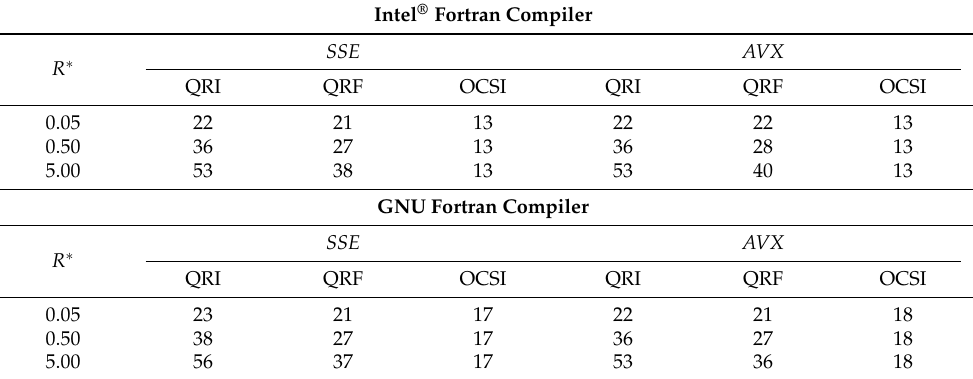
Table 2. Average run-times of the F90 version of algorithms for collision detection between one L ∗ W ∗ cuboid of 1 20 and 1 20 and one sphere of radius R ∗ over 2 ≤ ≤ ≤ ≤ with 40% of acceptance ratio. Results, reported in ms, are obtained compiling the benchmark program using Intel Fortran ® Compiler and GNU Fortran Compiler, enabling the generation of SSE and AVX instructions. The standard deviations of all the run-times are <0.5